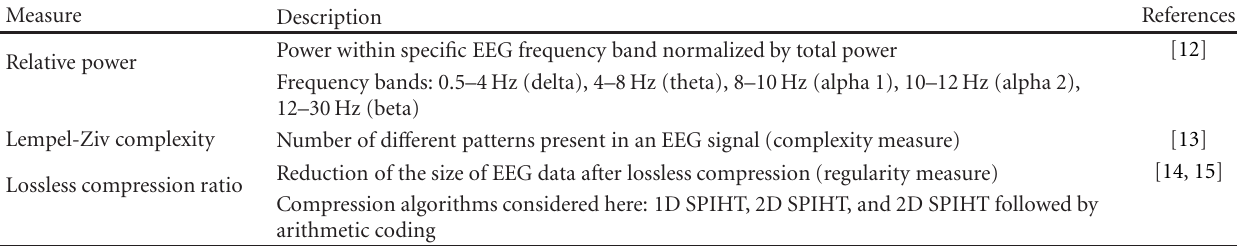
Table 1: Overview of statistical measures: relative power, Lempel-Ziv complexity, and lossless compression